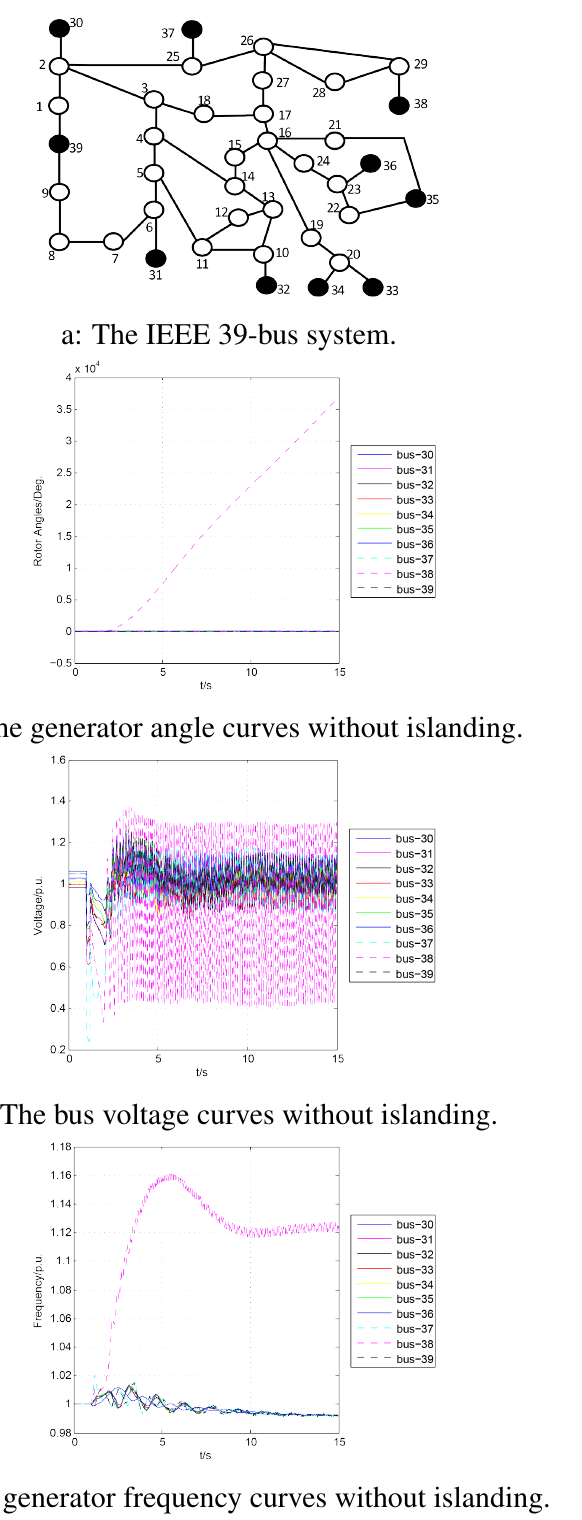
Figure 18. Comparisons with and without the islanding on the IEEE 39-bus